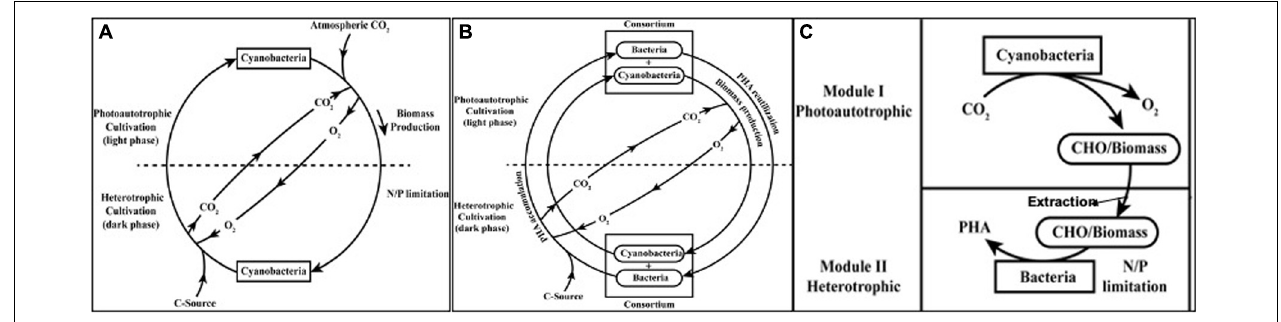
FIGURE 3 | Strategies and culture regime of “hybrid biological system” for PHA production improvement. (A) Mixotrophy; (B) Photoautotrophic-heterotrophic consortium; and (C) Two module system.